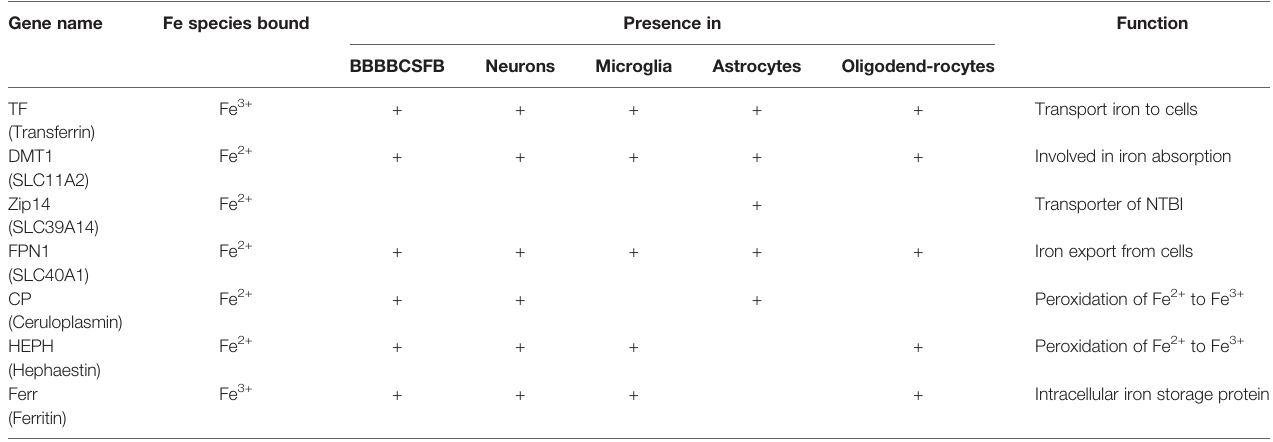
TABLE 2 | Proteins Involved in Brain Iron